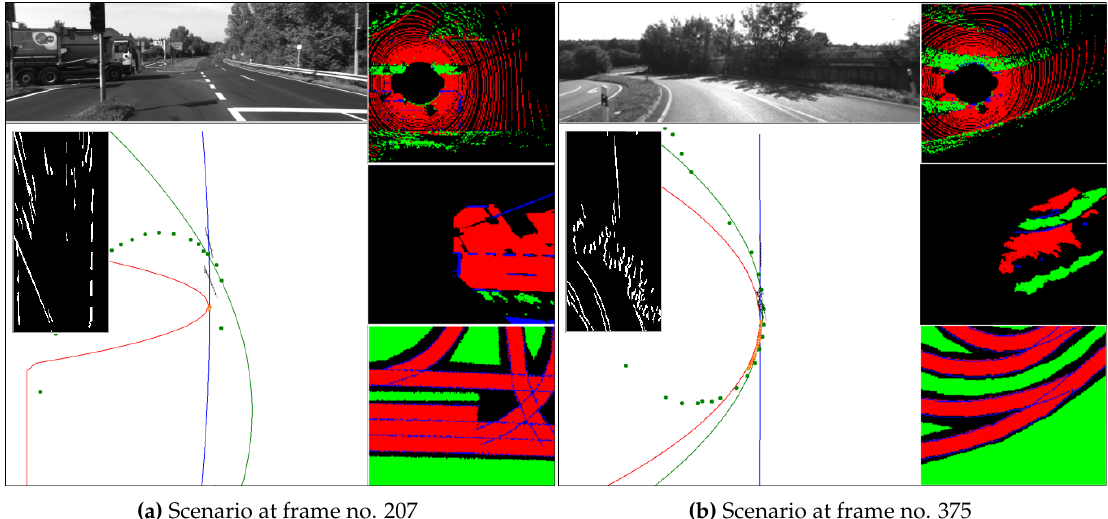
Figure 5. Specific scenarios from dataset 2011_09_26_drive_ 0029. Top left: view of the scenario; bottom left: model fitting; left inset: lane-marking detections; top-right: feature grid (FG) of LiDAR; middle right: FG of vision; bottom right: FG of